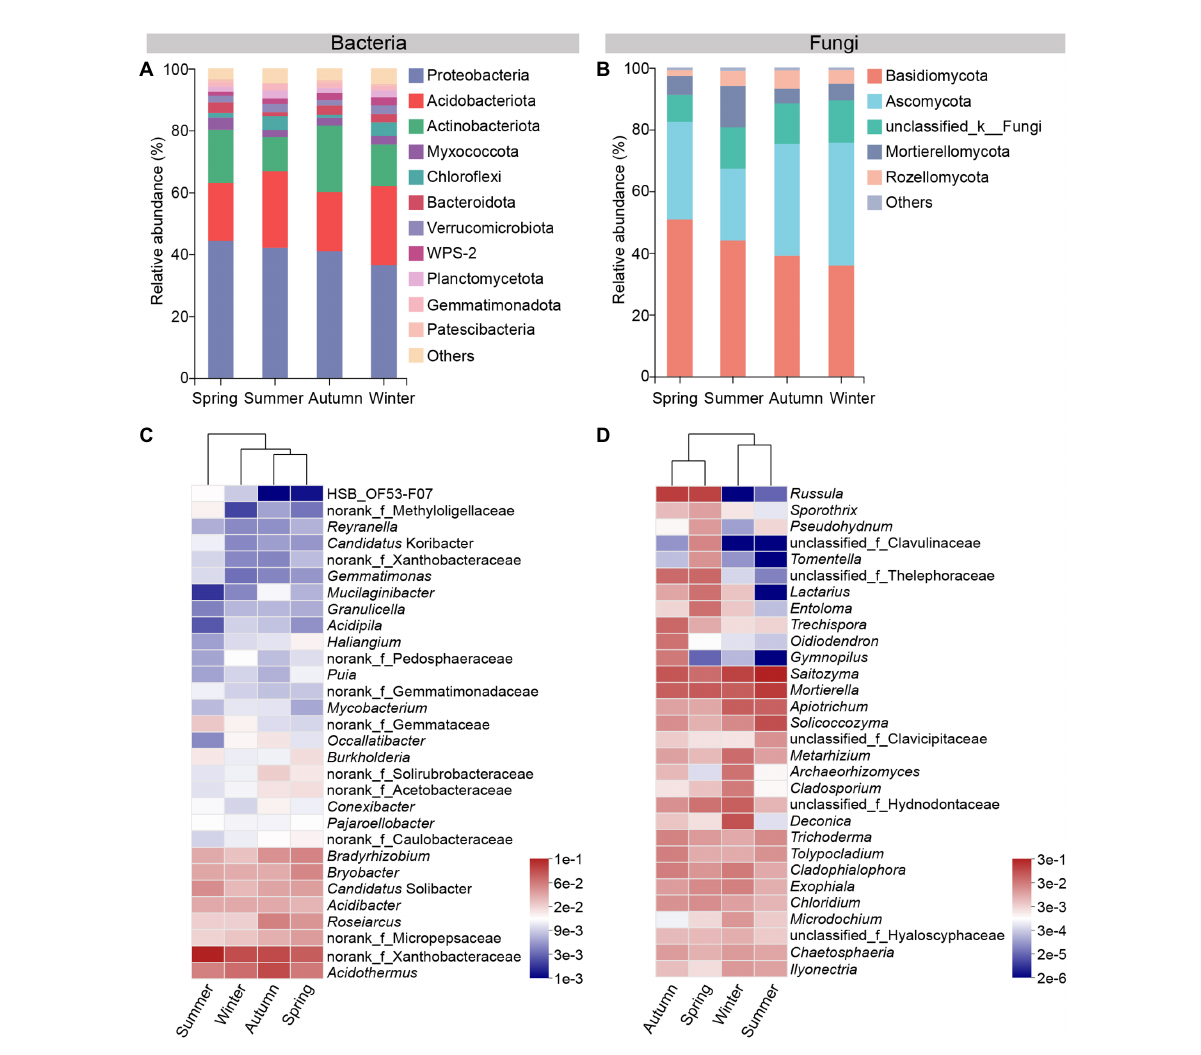
Figure 4C. Saprotrophic fungi occupied a high proportion (more than 20%) in C . pingbianense rhizosphere soil of each season, including soil saprotroph (e.g., Apiotrichum ), wood saprotroph (e.g., Trechispora ), undefined saprotroph (e.g., Trichoderma ) and so on. The relative abundances of symbiotrophic fungi were significantly higher in spring (25.63%) and autumn (22.70%) samples than those in summer (1.82%) and winter (2.88%), and the predominant species were ectomycorrhizal fungi, including Russula , Lactarius , Chloridium , etc. Pathotrophic fungi had the highest relative abundance (6.96%) in the winter sample, mainly including animal pathogens such as Metarhizium . Moreover, in all seasons, Saitozyma and Mortierella belonging to multiple trophic modes were dominant in soil fungal